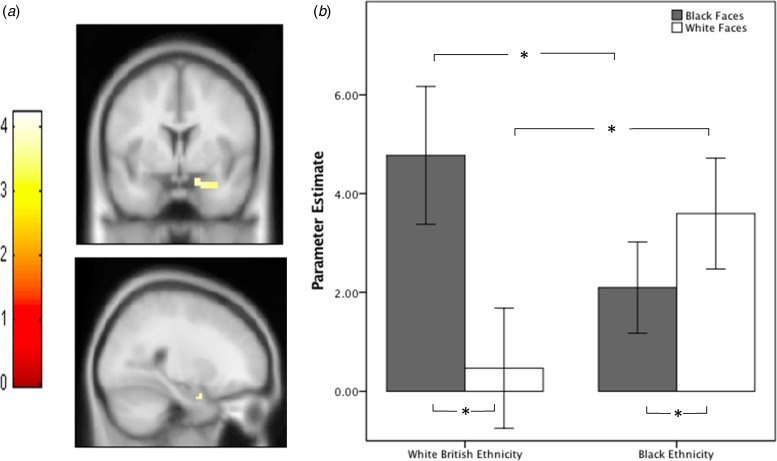
(a) Increased amygdala activation in black ethnicity group compared with white British ethnicity group for white > black faces contrast during 525 ms presentations. Functional maps are unmasked and thresholded at p < 0.001 whole brain, uncorrected for display purposes. (b) Mean parameter estimates for right amygdala region of interest (ROI) for both groups, for faces (525 ms) v. white square contrasts, error bars = ±SEM. *p < 0.05.